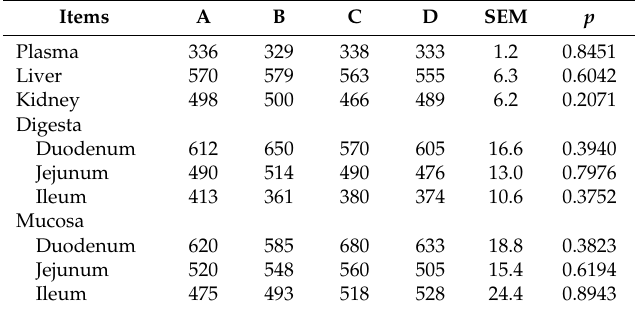
Table 2. Effect of betaine on osmolarity of high-salt stressed Sprague–Dawley rats (mOsm/kg). Items A